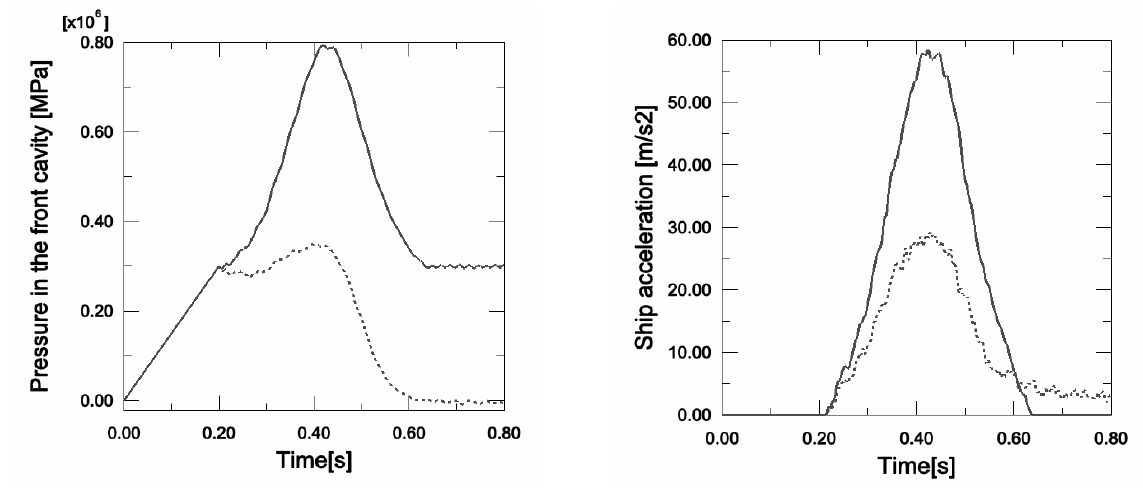
Fig. 7. Passive response (continuous line) and semi-active adaptation with pressure release (dashed line): a) pressure in the front chamber, b) corresponding ship